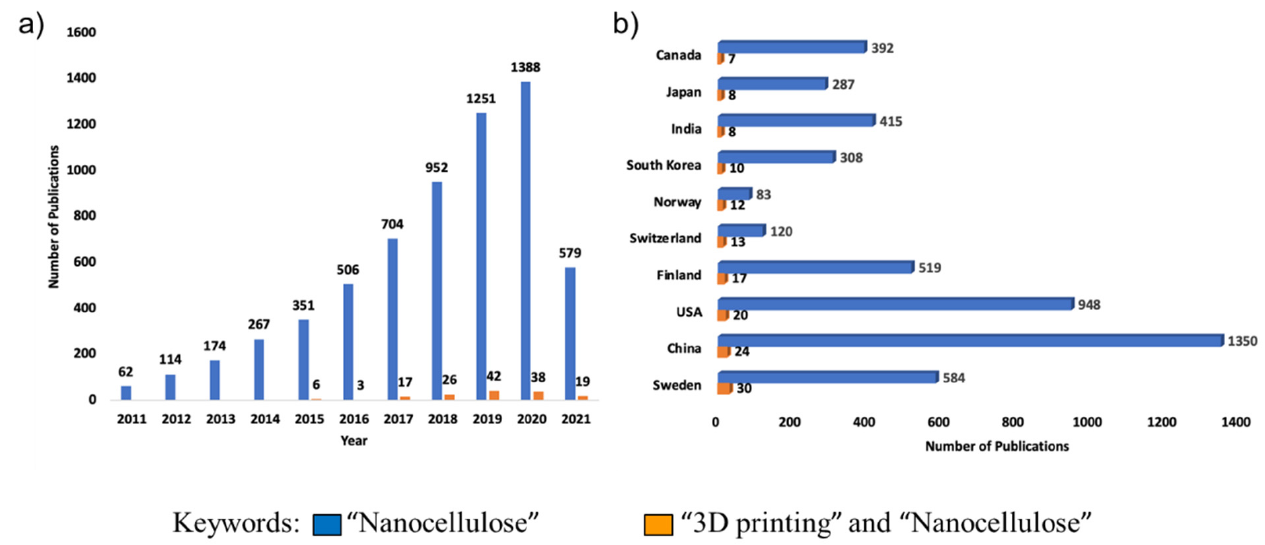
Figure 2. Graphs showing the number of publications between 2011–2021 ( a ) and publications per country ( b ) using Web of Science (accessed on 30 June).